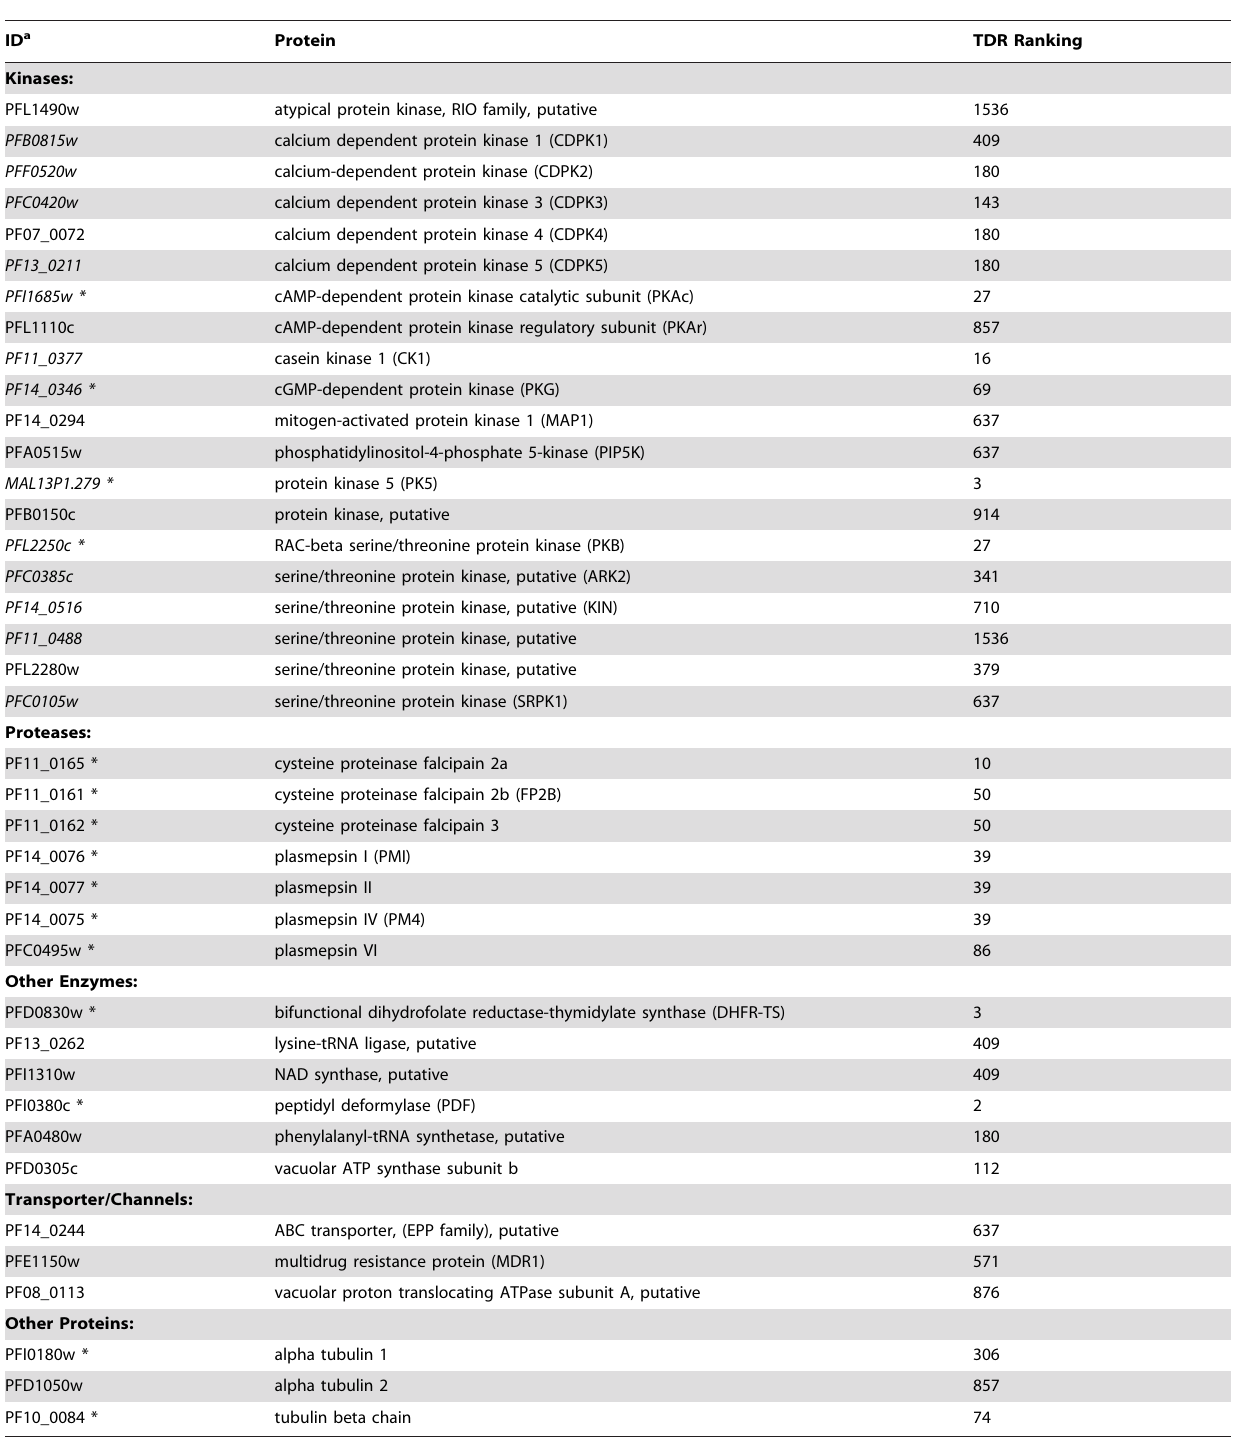
Table 1. List of predicted 39 high priority malaria targets and their TDR ranking.